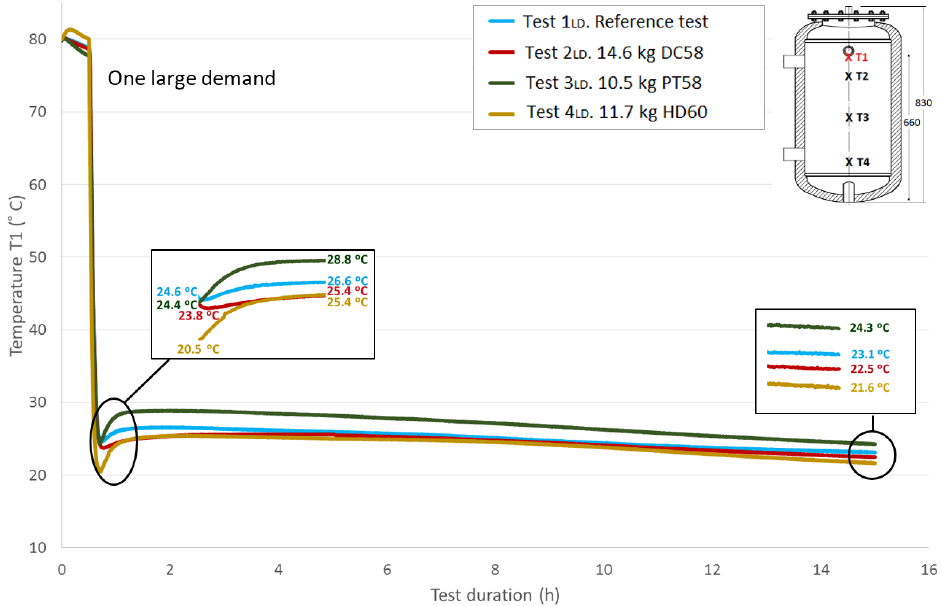
Figure 8. Top height water temperature ( T 1) inside the tank during one large demand experiment. (dimensions are in mm). (dimensions are in